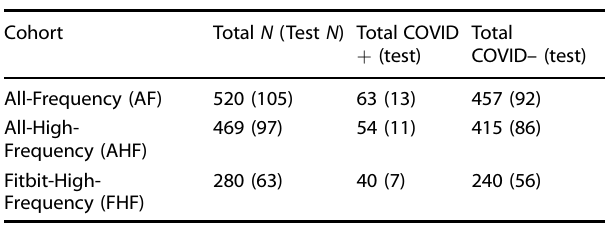
Table 1. Summary of the